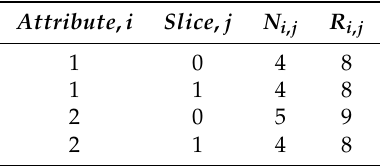
Table 5. Determined bit-slice length, N and maximum bit-length, R